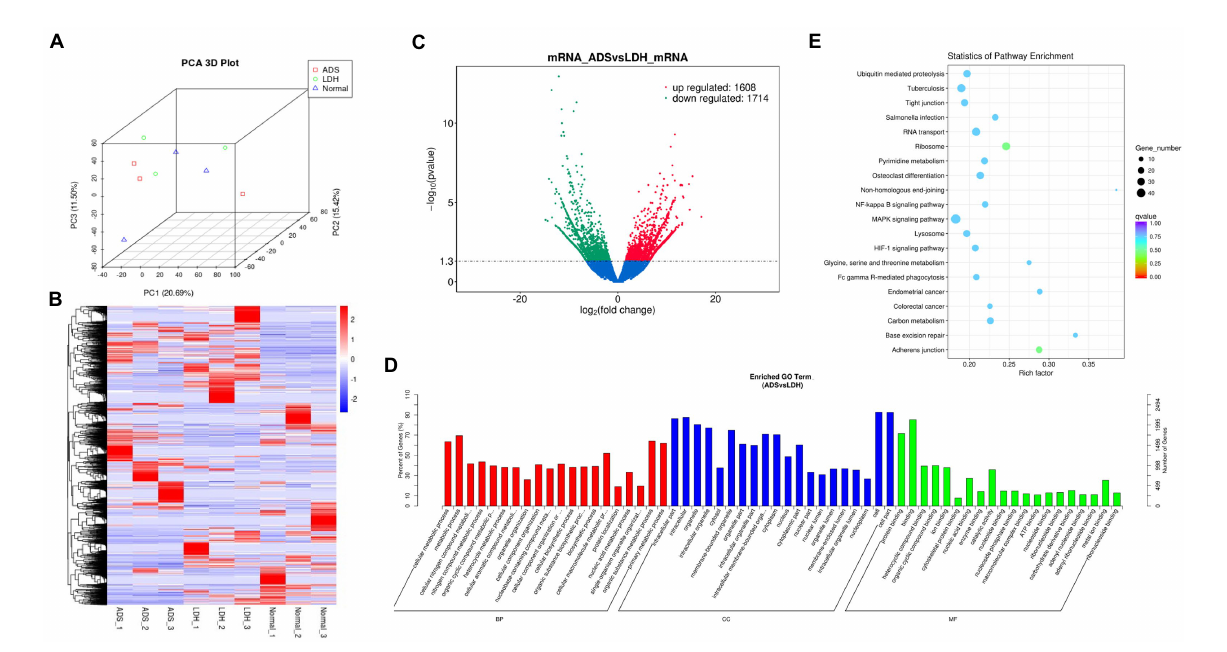
FIGURE 2 Identification of differentially expressed mRNAs in ADS (A) Principal component analysis shows the clustering of mRNA in different samples. (B) Hierarchical clustering illustrates distinguished expression difference of mRNA and between the three groups and homogeneity between groups. (C) Volcano plot showing differentially expressed mRNAs in ADS and LDH group. (D) The 20 most enriched Gene Ontology terms for the parental genes of the differentially expressed mRNAs. Enriched GO terms are on the vertical axis, and the number of annotated differentially expressed genes associated with each GO term is indicated on the horizontal axis. (E) The 20 most enriched KEGG pathways for the differentially expressed mRNAs. The size of the symbol represents the number of genes, and the colors represent p